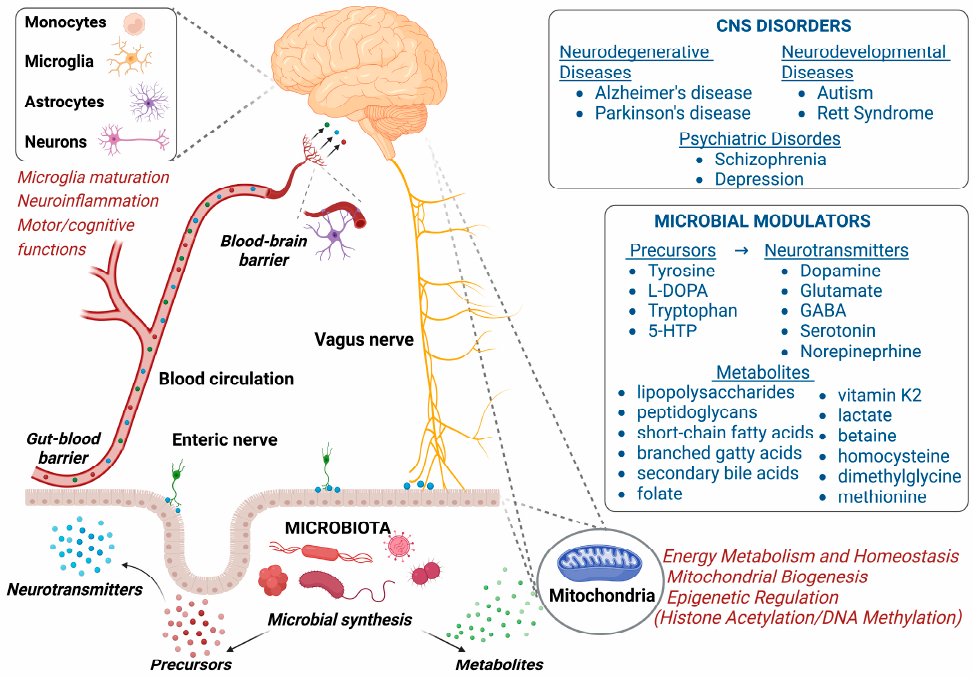
Figure 2. Schematic model of the gut microbiota-brain axis interplay. The crosstalk between gut microbiota and mitochondria is involved in many CNS disorders, as reported in the right-upper panel. Microbial modulators are listed in right-lower panel. Left figure: Neurotransmitters and their precursors, as well as metabolites, produced directly by the gut microbiota and/or through dietary metabolism can cross the gut-blood barrier and enter the bloodstream. Some of them can cross the blood–brain barrier to directly affect brain functions (microglia maturation, neuroinflammation, and motor and cognitive functions). In addition, gut microbiota-modulated changes in neurotrans- mitter/precursor synthesis may also lead to alterations in sensory signals transmitted to the brain through the enteric and vagus nerves. Finally, the microbiota metabolites also affect the hosts energy metabolism, homeostasis, and gene expression by influencing the in situ mitochondria of the gut epithelium and distal mitochondria of the brain cells. Created with BioRender.com (accessed on 2 November